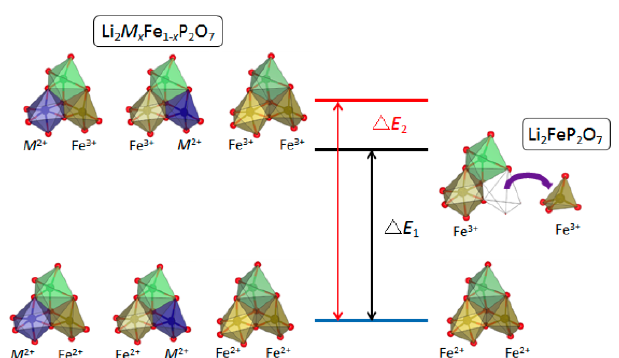
Figure 3. Schematic description of free energy difference between starting and delithiation materials. The right-hand portion is the pristine Li 2 FeP 2 O 7 system. The spontaneous structural rearrangement (Fe’s migration) destroys the edge-sharing configuration and decreases the free energy of the delithiated state, which results in an energy difference of △ E 1 . The left-hand portion is the doping system Li 2 M x Fe 1- x P 2 O 7 . After full delithiation, the Li concentration is higher than that in the Li 2 FeP 2 O 7 case, because all of the M ions remain inert. The remaining Li can block the Fe migration and can stabilize the Fe’s original local structure and the whole crystal structure, which means that the energy difference △ E 2 should be higher than △ E 1 .